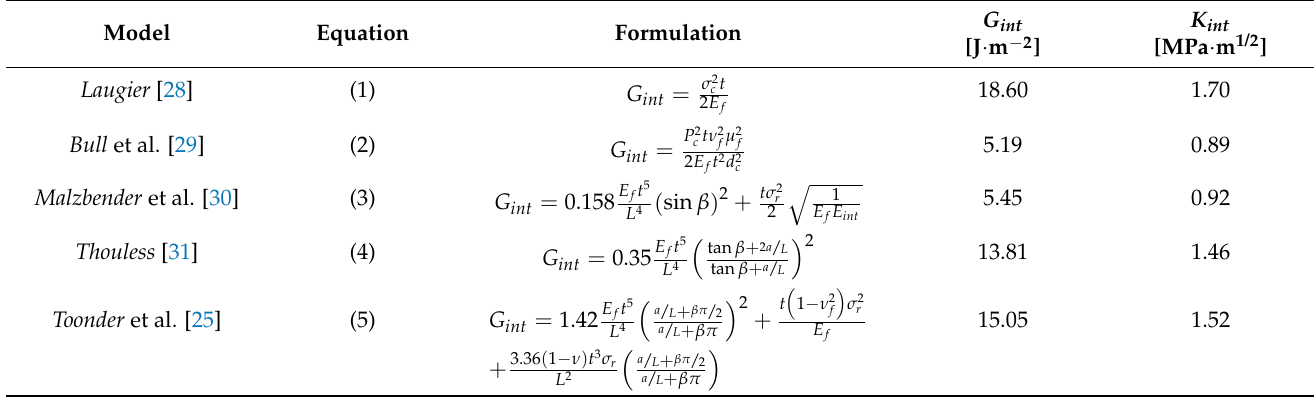
Table 1. Models for calculating the adhesion energy and corresponding average values of calculated G int and K int.